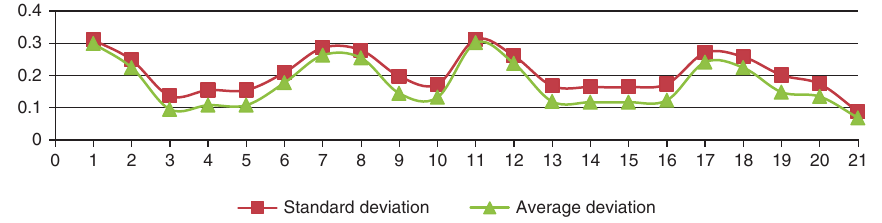
Figure 4: Standard/Average Deviation Results for Proposed 21 Measures on Score Classes 1–2 with MSR